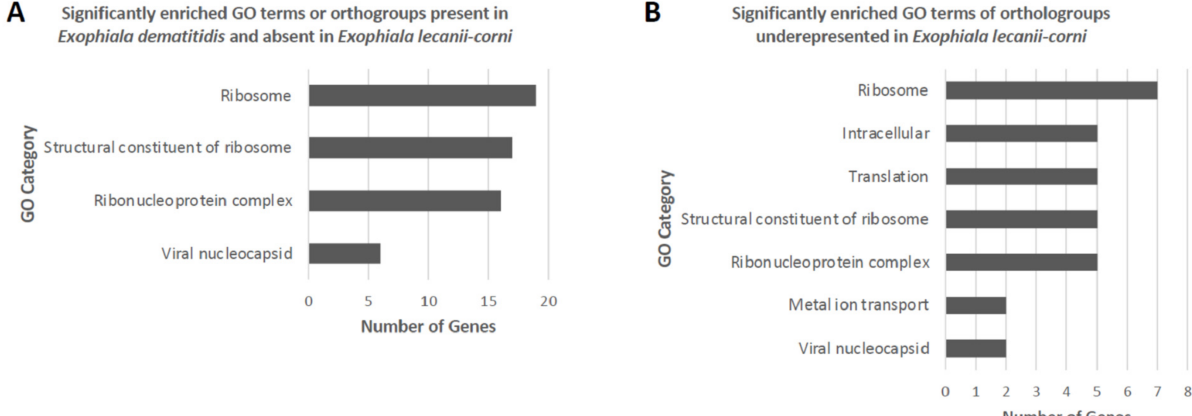
Figure 8. Significantly enriched ( p < 0.05) GO categories of orthologues identified using OrthoFinder that are absent in E. lecanii-corni relative to ( A ) all species including in this analysis, and ( B ) E. dermatitidis